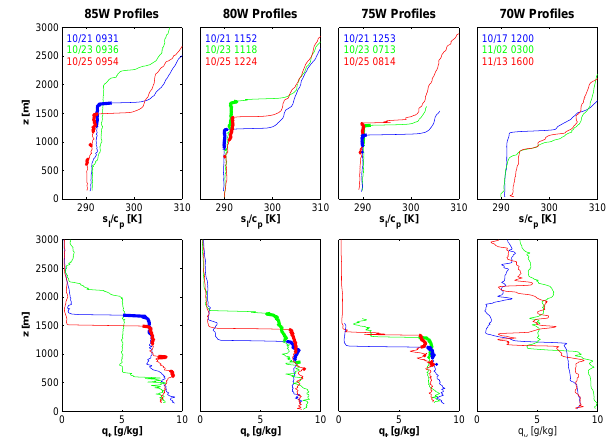
Fig. 4. Representative profiles along 20 ◦ S of θ and q v from Iquique (70 ◦ W), and of θ l and q t from the C130 near 75, 80 and 85 ◦ W. The C130 profiles are thickened where q l > 0 . 02gkg − 1